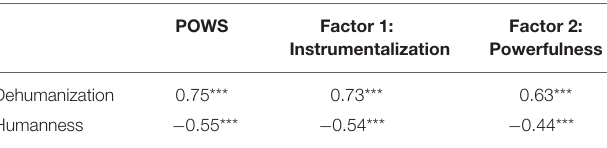
TABLE 6 | Correlations between perception of objectification at work (POWS scale), dehumanization, and humanization ( N = 74).